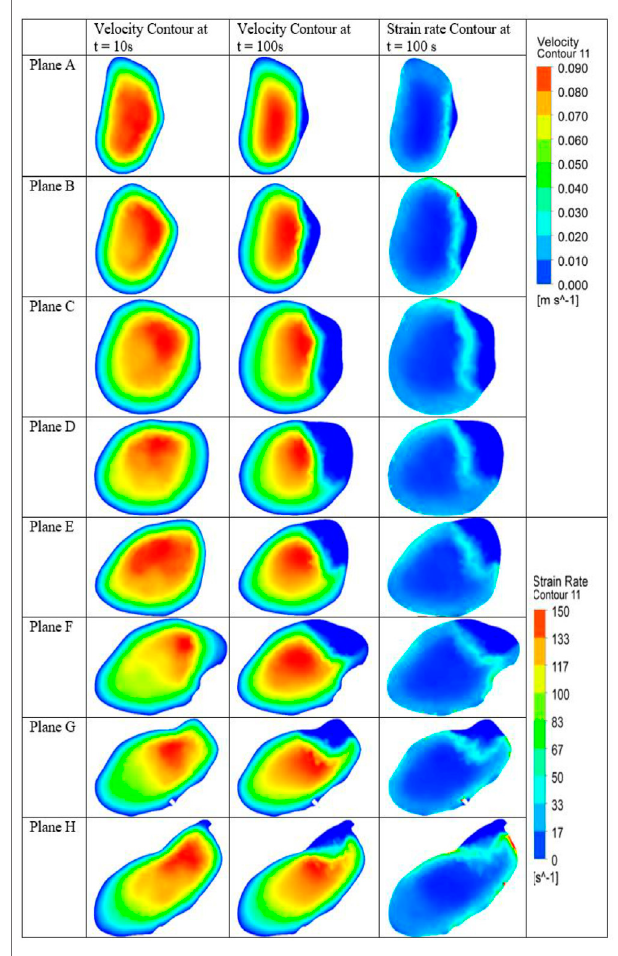
FIGURE 14 | Contours comparing velocities on planes before (t = 10 s) and after (t = 100 s) clot formation. Strain rate contours show an increased strain rate on the clot surface (patient-speci fi c